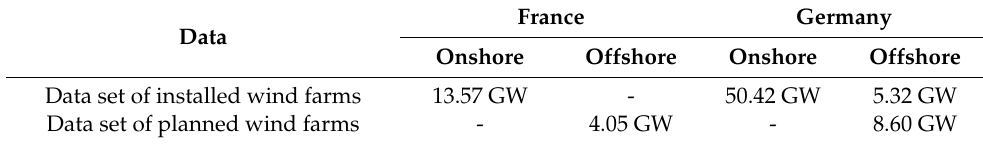
Table 1. Wind dataset that contains geographical information.